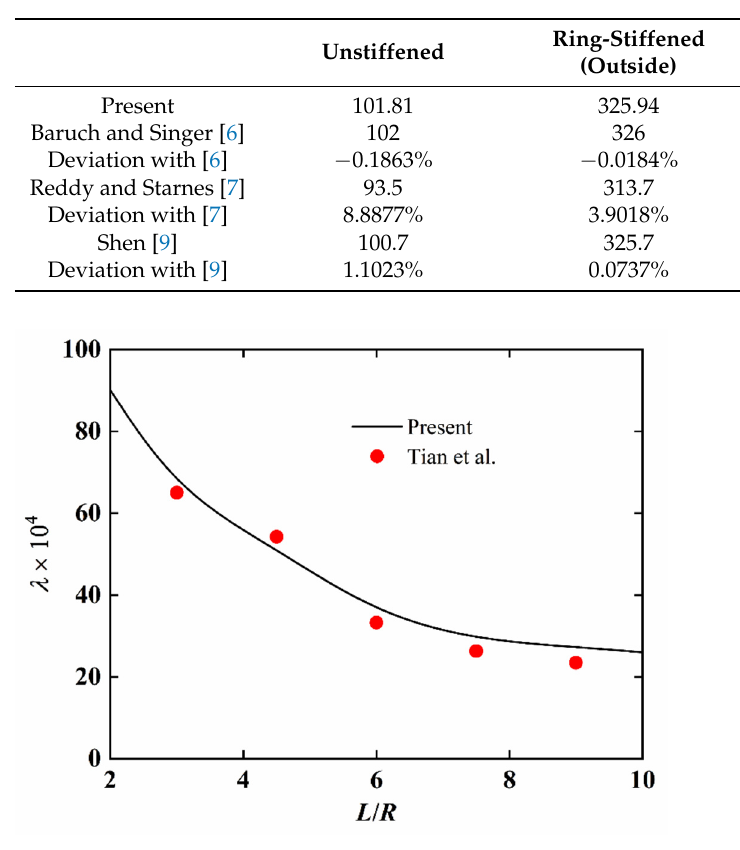
Figure 4. Variation in dimensionless critical load parameter of homogeneous isotropic ring-stiffened cylindrical shells with length–radius ratios [11].